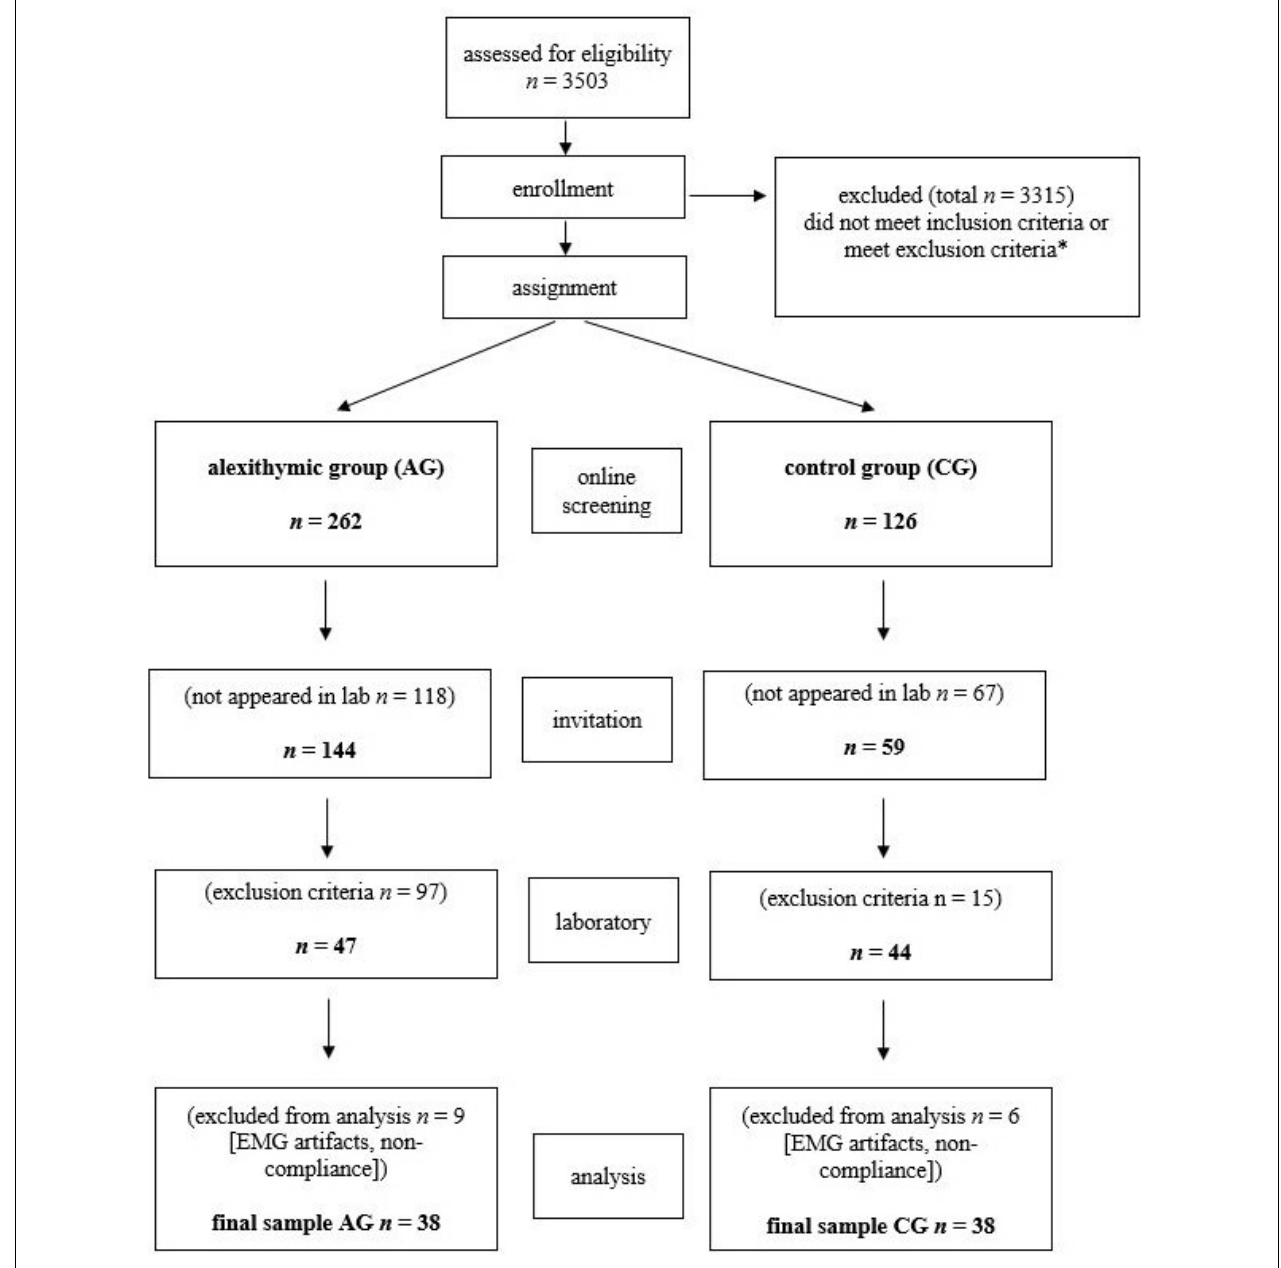
FIGURE 1 | Flow of the participants for the given study procedures, assignment, and analysis. *Exclusion criteria were age < 19 or > 50 years, neurologic disease, particularly facial paresis, severe psychiatric disease, insufficient language skills; PHQ-9 sum-score <